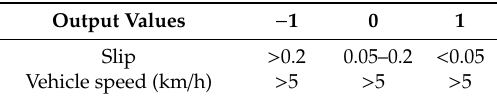
Table 1. ABS controller logic.